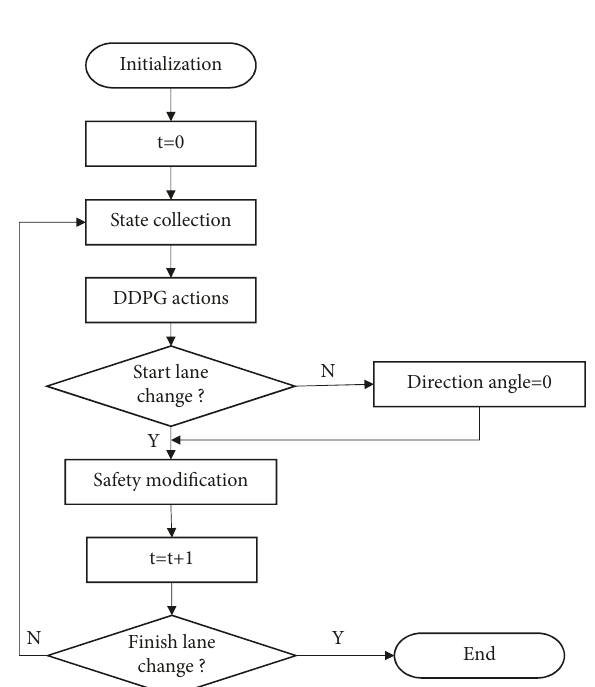
Figure 4: The lane-changing model framework.